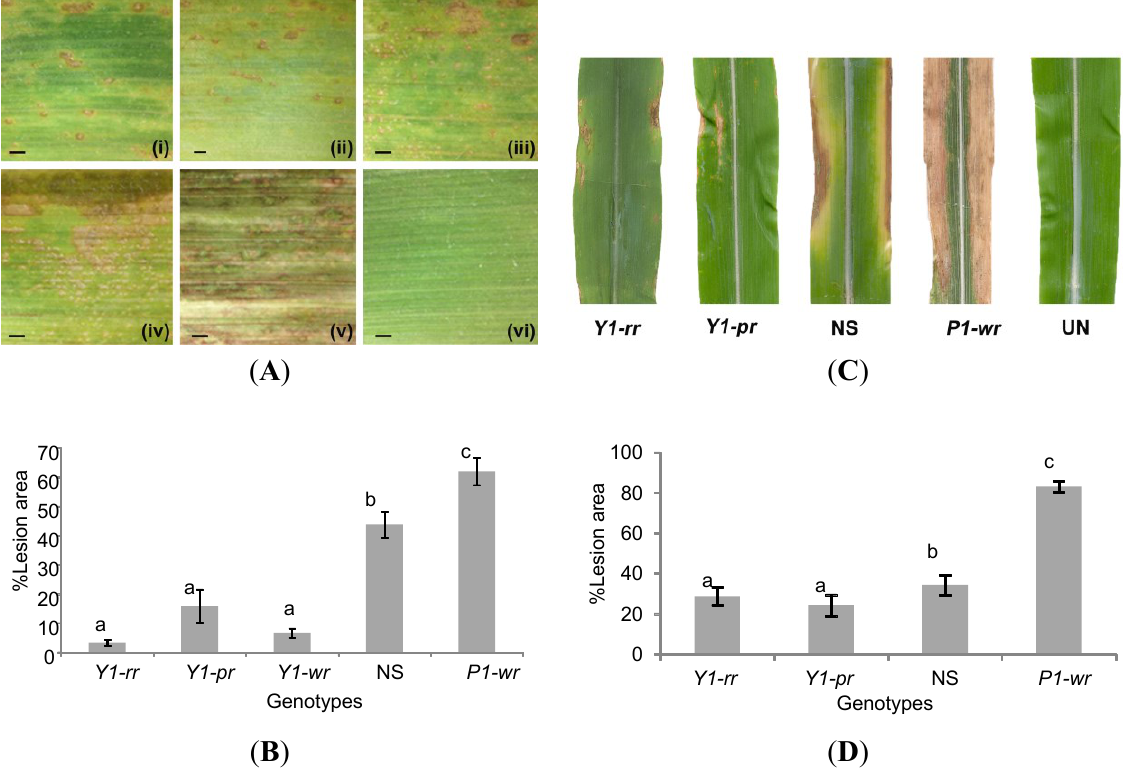
Figure 4. Sorghum y1 gene enhances resistance against C. heterostrophus and C. graminicola in Y1- maize. ( A ) Detached leaf assay showing disease symptoms that developed 4 days post infection (dpi) when infected with C. heterostrophus . ( i ) Y1-rr ; ( ii ) Y1-pr ; ( iii ) Y1-wr ; ( iv ) NS; ( v ) P1-wr ; ( vi ) un-inoculated Y1-pr . Scale bar indicates 1 mm. ( B ) Quantification of the lesion area 4 dpi with C. heterostrophus . Values shown are the mean ± SE. ( C ) Symptoms that developed 11 dpi when whole plants were infected with C. graminicola . ( D ) Quantification of lesion area 11 dpi with C. graminicola . Values shown are the mean of 44 replicates ± SE. The x-axis in Figure 4A,C shows different genotypes used: Y1-rr , Y1-pr , Y1-wr ; NS and P1-wr